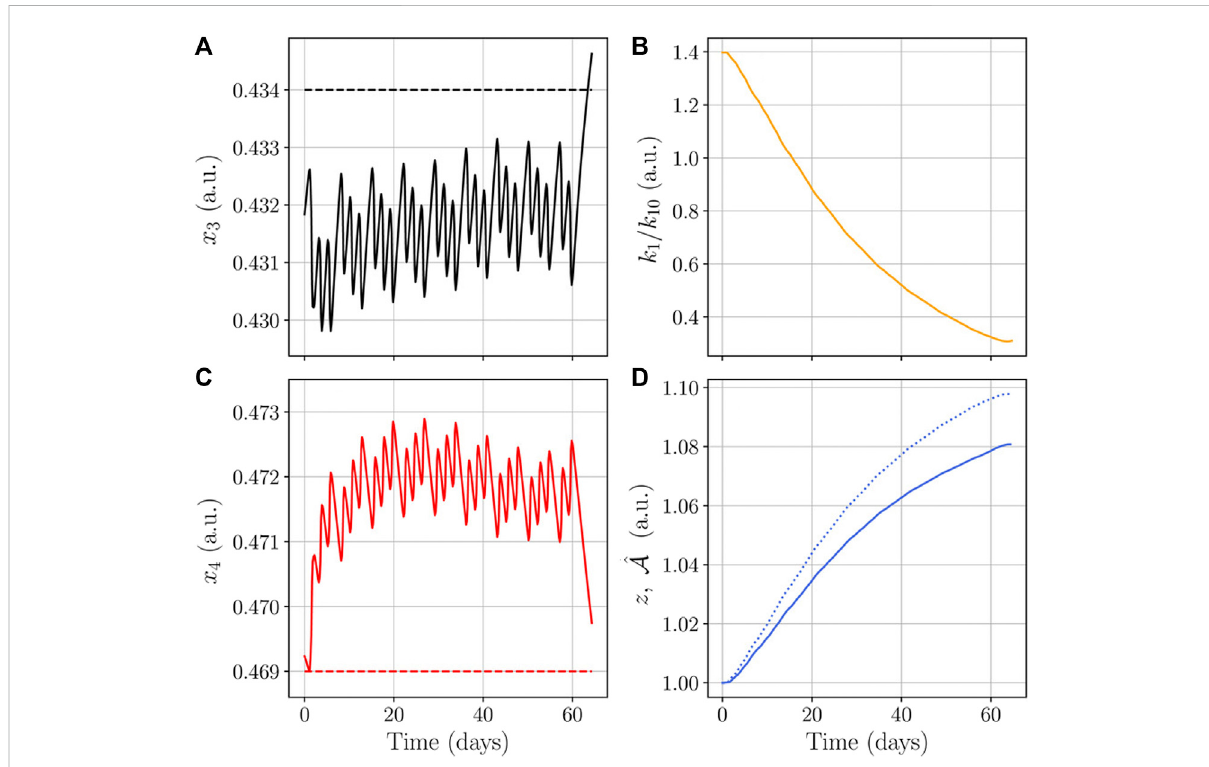
FIGURE 9 Biochemical variables andproteinsynthesisrate during theCSA adaptation shown inFigure8.Dashedlines representthresholdlevelsin fi gures (A,C) ; these fi gures show that periodic training leads to oscillations of x 3 below its threshold, and x 4 above its threshold; those levels favor hypertrophyaccording toEq. 2. Figures (B,D) show that proteinsynthesis rate decreases as z increases. And fi gure (D) shows theresults presented in Figure 5 after the use of function β ( A , F ) as feedback; recall that the elastic response required for compatible con fi guration explains the difference between z (continuous line) and ^ A (dotted line). (a.u., arbitrary